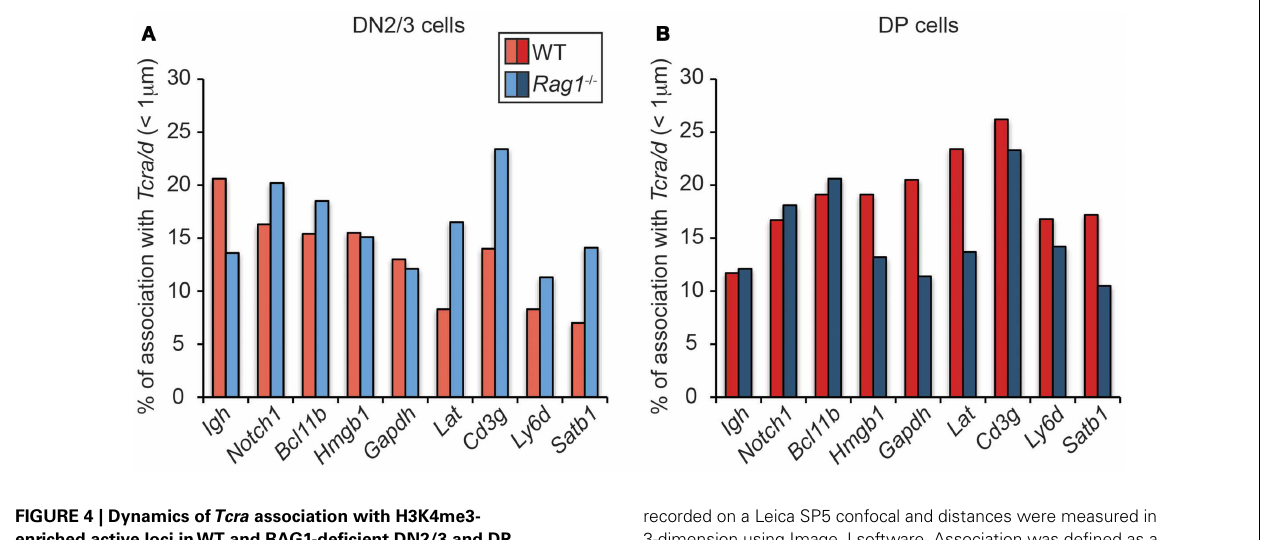
FIGURE 4 | Dynamics of Tcra association with H3K4me3- enriched active loci inWT and RAG1-deficient DN2/3 and DP cells . DNA FISH was performed using fluorescent BAC probes for Tcra , Igh , and the H3K4me3-enriched active loci, images were